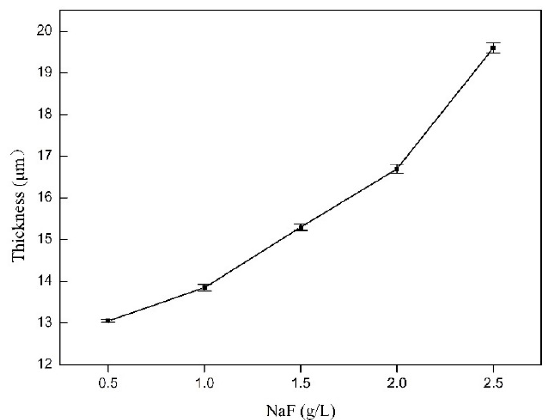
Figure 2. Cross-sectional SEM micrographs of MAO coating with different NaF concentrations: ( a ) 0.5 g/L; ( b ) 1 g/L; ( c ) 1.5 g/L; ( d ) 2 g/L; ( e ) 2.5 g/L.